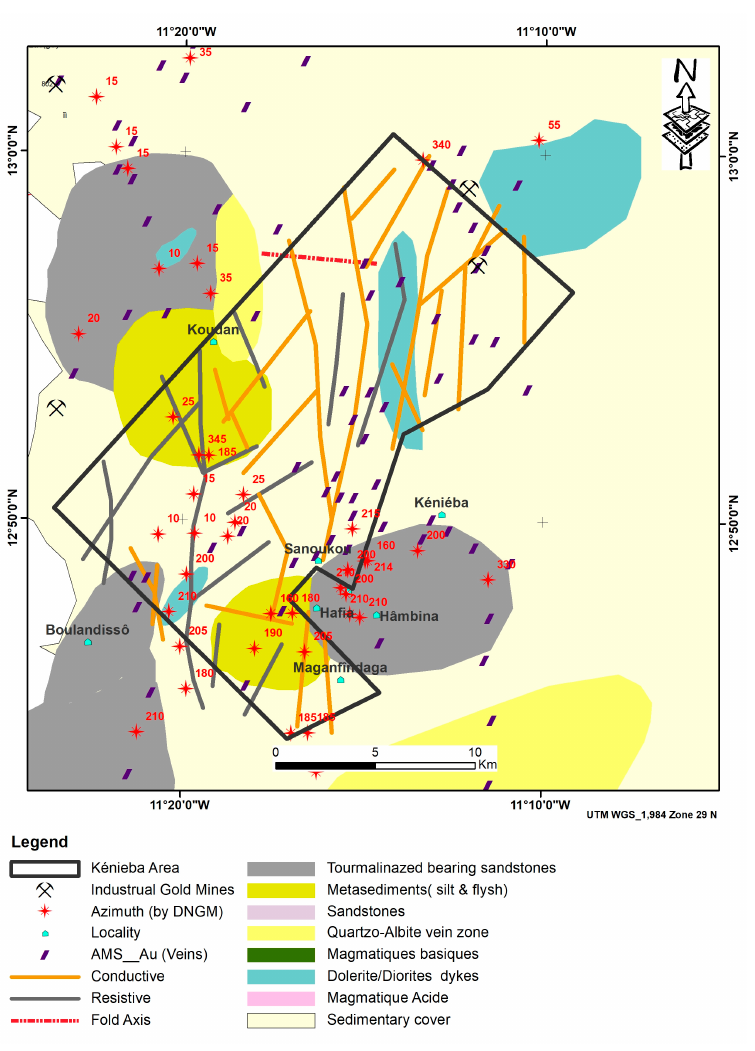
Figure 6. Electromagnetic interpretations compilated into a Geological map from field observation.